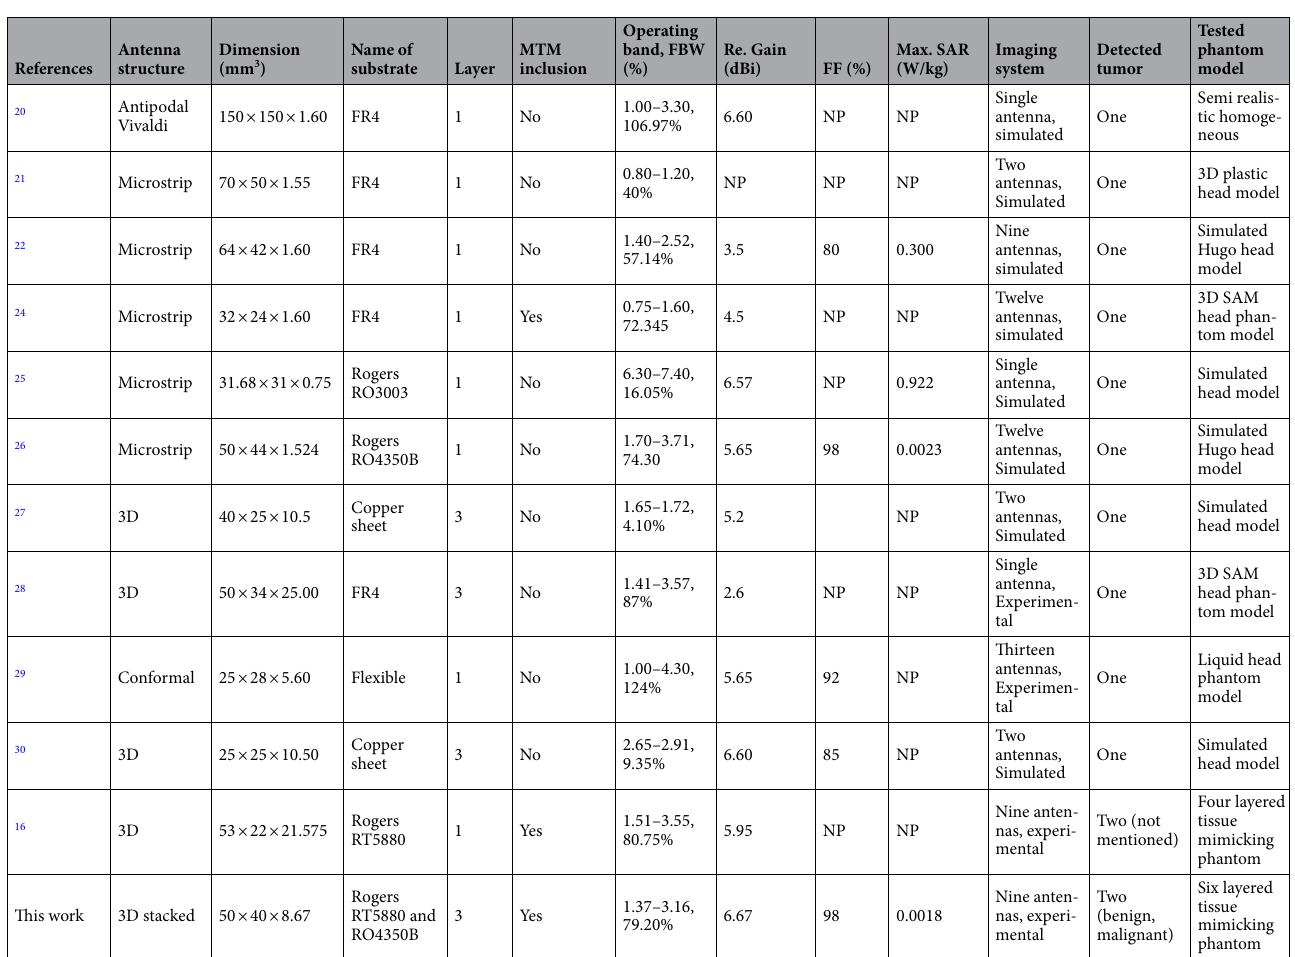
Table 9. Overall observation and comparison of the proposed antenna with the state-of-the-art. * NP Not